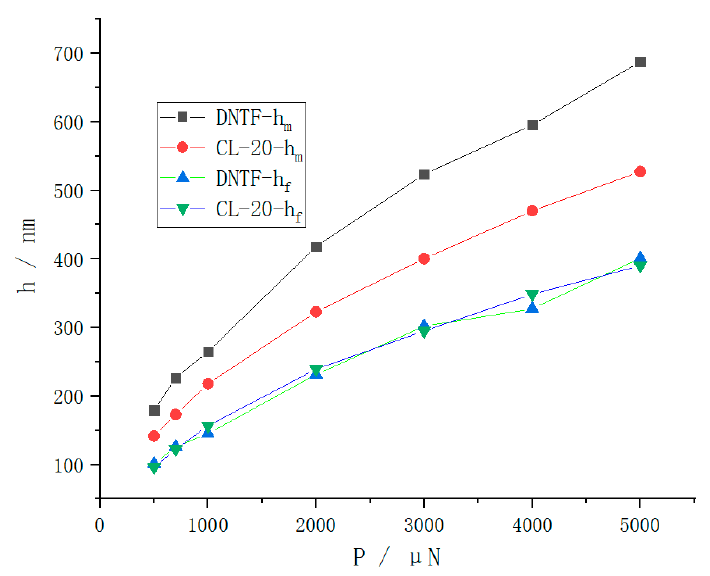
Figure 4. Load–displacement variation curve.